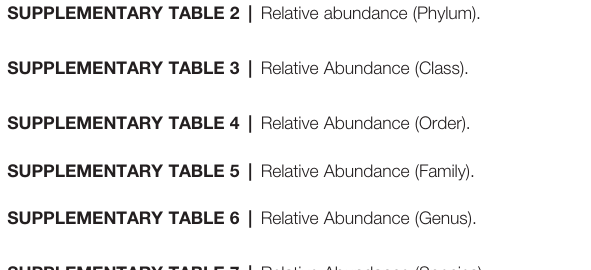
SUPPLEMENTARY FIGURE 1 | Sequencing read statistics. SUPPLEMENTARY FIGURE 2 | Alpha-rarefaction Analysis. SUPPLEMENTARY FIGURE 3 | Real-Time PCR Quanti fi cation of Total 16S RNA Gene Sequencing. SUPPLEMENTARY TABLE 1 | Sequence read statistics and alpha diversity indices. SUPPLEMENTARY TABLE 2 | Relative abundance (Phylum).